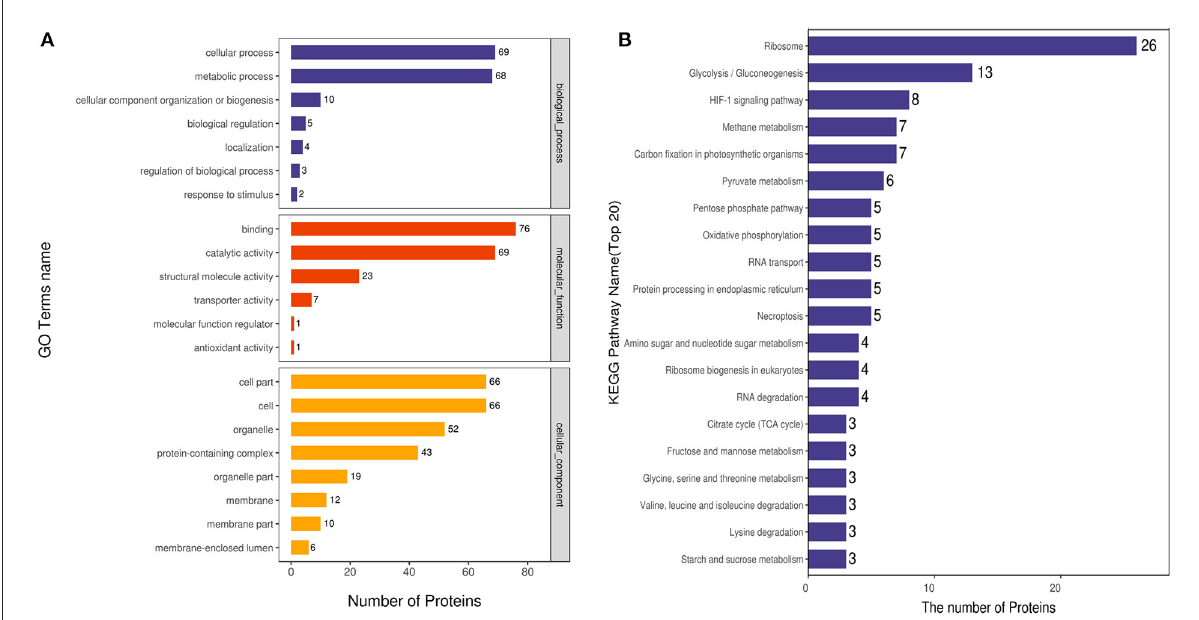
FIGURE4 GO and KEGG pathway analyses of DEAPs. (A) GO classification of differentially expressed acetylated proteins. (B) KEGG pathway analysis of differently expressed acetylated proteins.